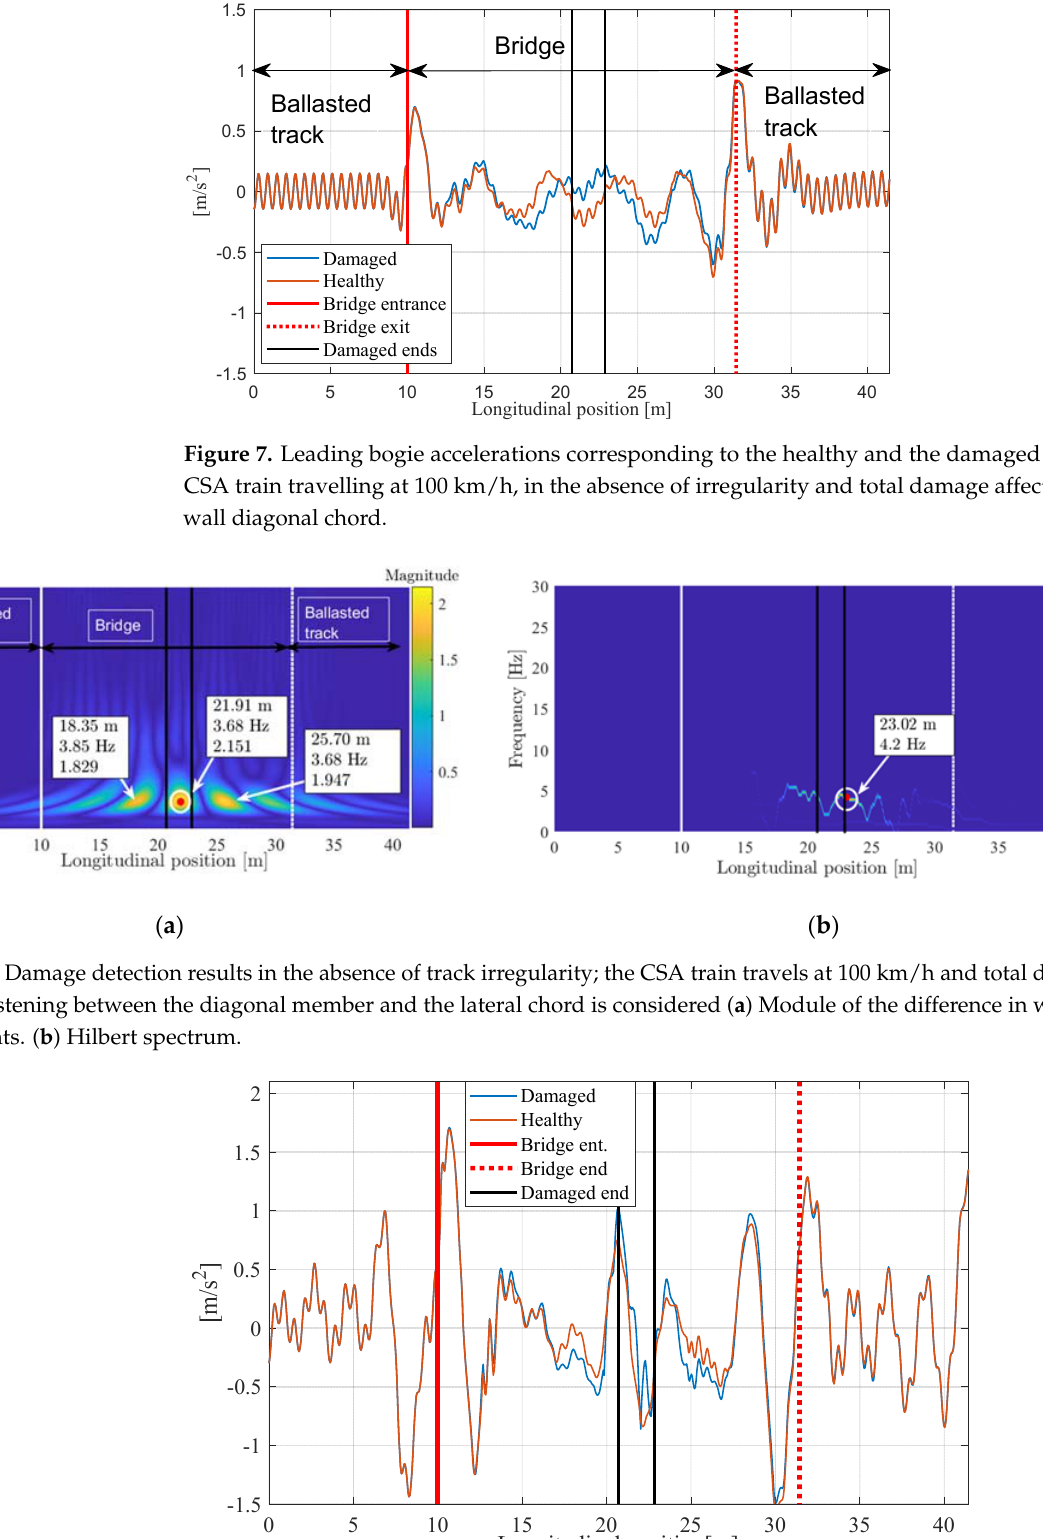
Figure 9. Leading bogie front right accelerations in the case of the healthy and the damaged bridge, respectively, and the time-invariant irregularity profile. Results are for the CSA train travelling at 100 km/h.